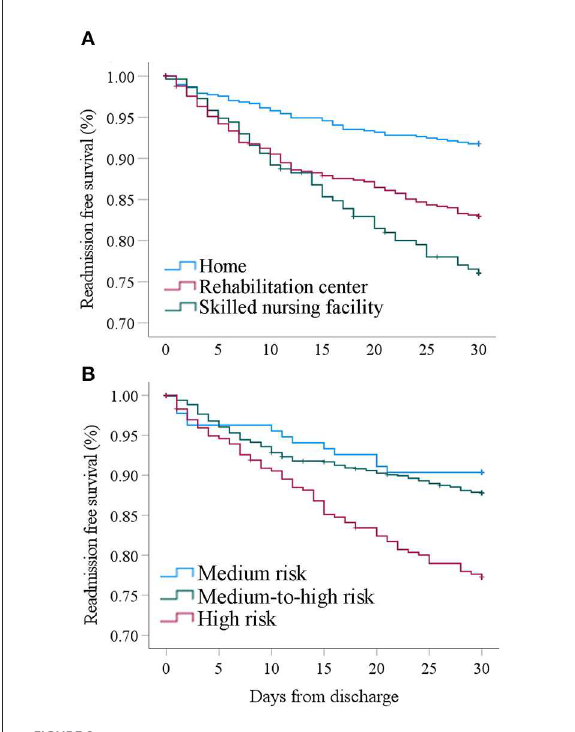
survival stratified by LACE + risk category.